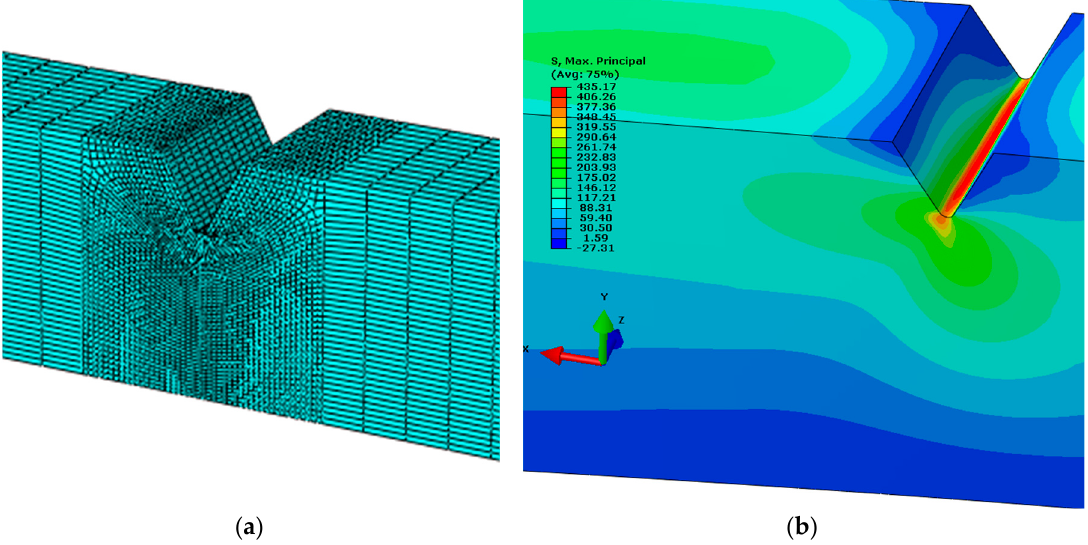
Figure 8. Rectangular specimen subjected to mode I + III testing: ( a ) Notch mesh density; ( b ) principal stress distribution at the initial stage of the crack growth for load angle, α = 30 ◦ .